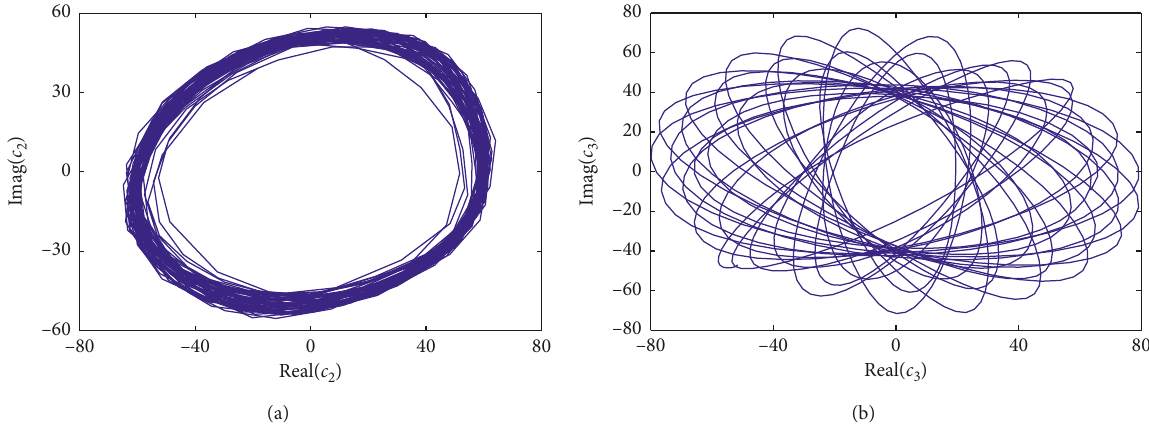
16, λ 0.05). (cid:31) (cid:31)